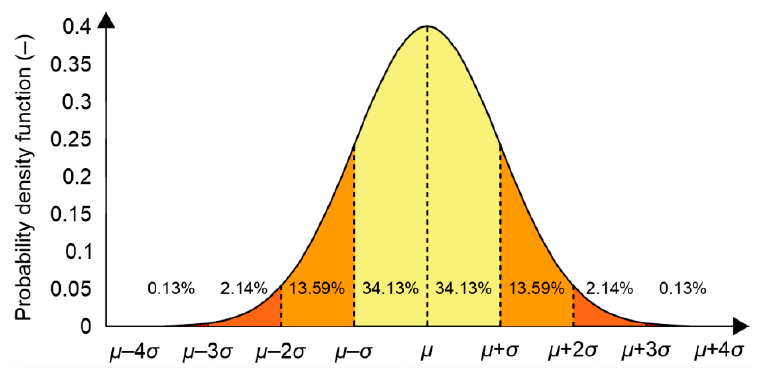
Figure 3. Normal probability density function.